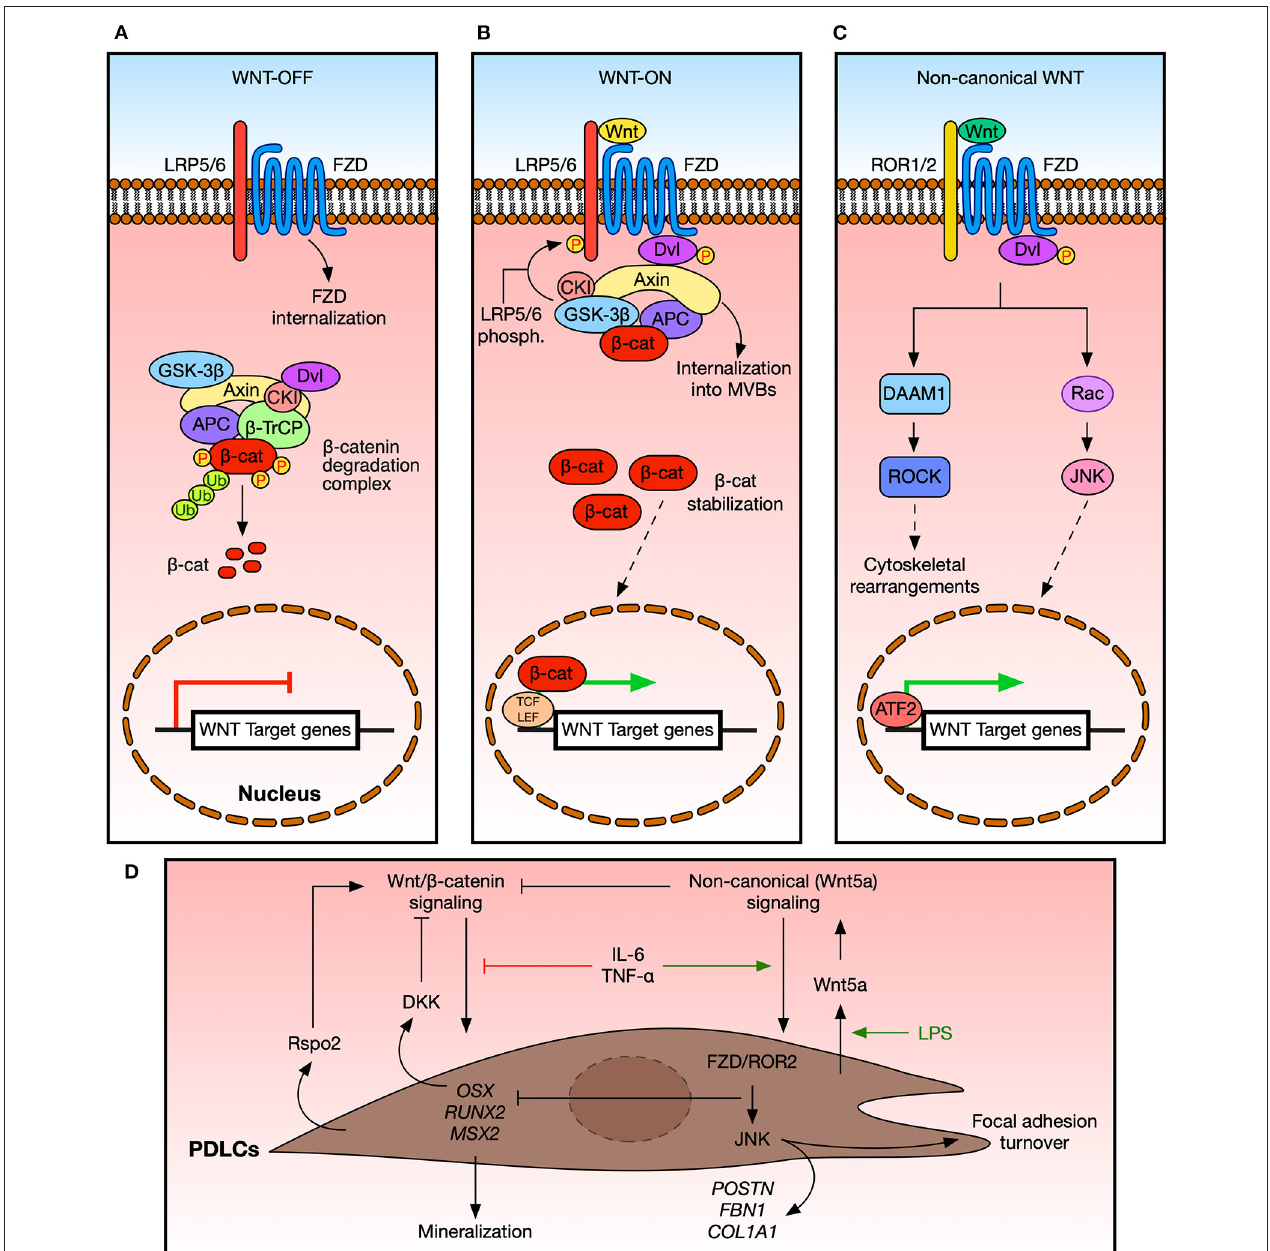
FIGURE 1 | Wnt signaling in the periodontal ligament in homeostasis. (A) Schematic representation of the Wnt/ β -catenin pathway. In the absence of Wnt ligands, a degradation complex targets β -catenin for phosphorylation and further degradation. Also, Frizzled (FZD) receptors might be cleared from the plasma membrane by the ZNRF3/RNF43 ubiquitin ligases (not shown). Wnt/ β -catenin target genes are not expressed in this context. (B) Schematic representation of the Wnt/ β -catenin pathway in the presence of Wnt ligands. The β -catenin destruction complex translocates to the plasma membrane in response to early activation events, including LRP5/6 phosphorylation. The destruction complex eventually becomes internalized into multivesicular bodies (MVBs) (10), and newly synthetized β -catenin becomes stabilized and translocate to the nucleus, where it binds to TCF/LEF transcription factors to promote the expression of target genes. (C) Simplified schematic representation of the non-canonical Wnt pathway. Here, Wnt ligands bind to FZD receptors and specific co-receptors, such as ROR1/2 or RYK. Intracellular effectors modulate specific aspects of cell behavior, such as cell migration. Also, ATF2-dependent transcription might be elicited. β -cat, β -catenin; WNT-OFF, pathway inactivation in the absence of ligands; WNT-ON, pathway activation in the presence of ligands. For simplicity, some components and receptors are not shown. (D) Cells from the periodontal ligament (PDLCs) are sensitive to different Wnt signals, which in turn promote different responses at the cellular level. Wnt/ β -catenin signals can promote the expression of osteogenic markers and the secreted inhibitor DKK1, thus modulating the activation of this pathway. On the other hand, non-canonical signaling mediated by Wnt5a might hamper the expression of osteogenic markers while promoting the expression of PDL-related genes and the turnover of cell-matrix adhesion. Additional cues, such as R-spondins, cytokines, or LPS, can modulate the response of PDLCs to specific Wnt inputs. See the main text for details.